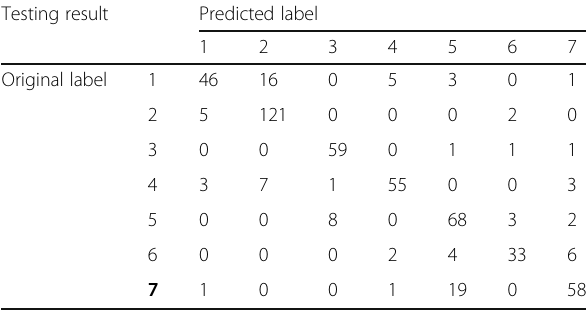
Table 6 Confusion matrix of the Berlin DB Testing